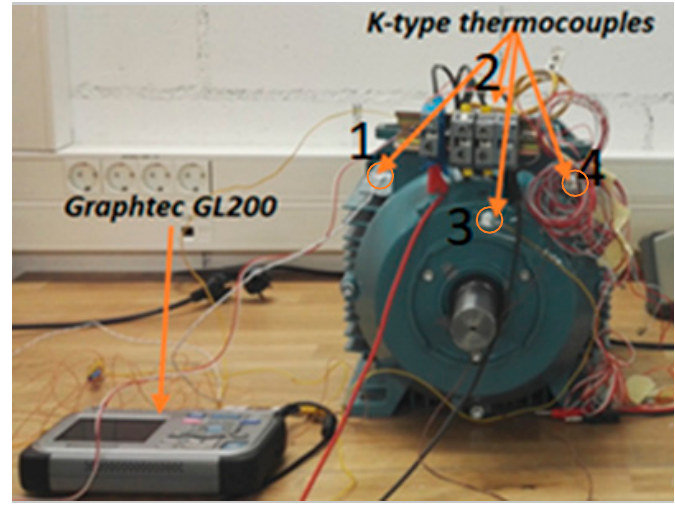
Figure 5. Passive cooling test setup.